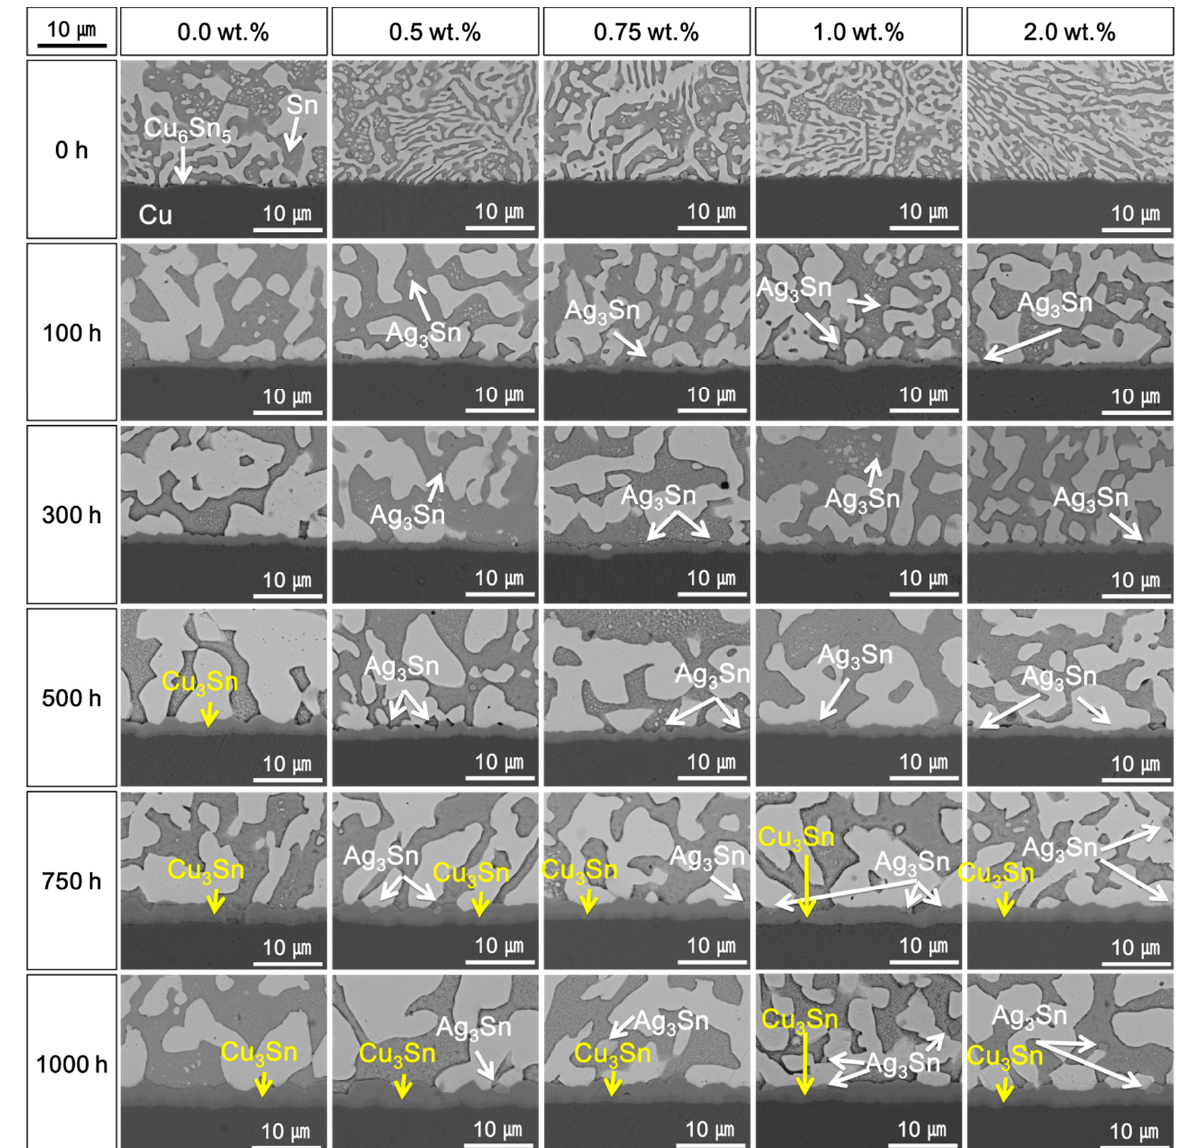
Figure 4. Cross-sectional scanning electron microscopy (SEM) micrographs of the Sn–58Bi Ag NP composite solder joints after high-temperature storage (HTS) tests at 115 °C .